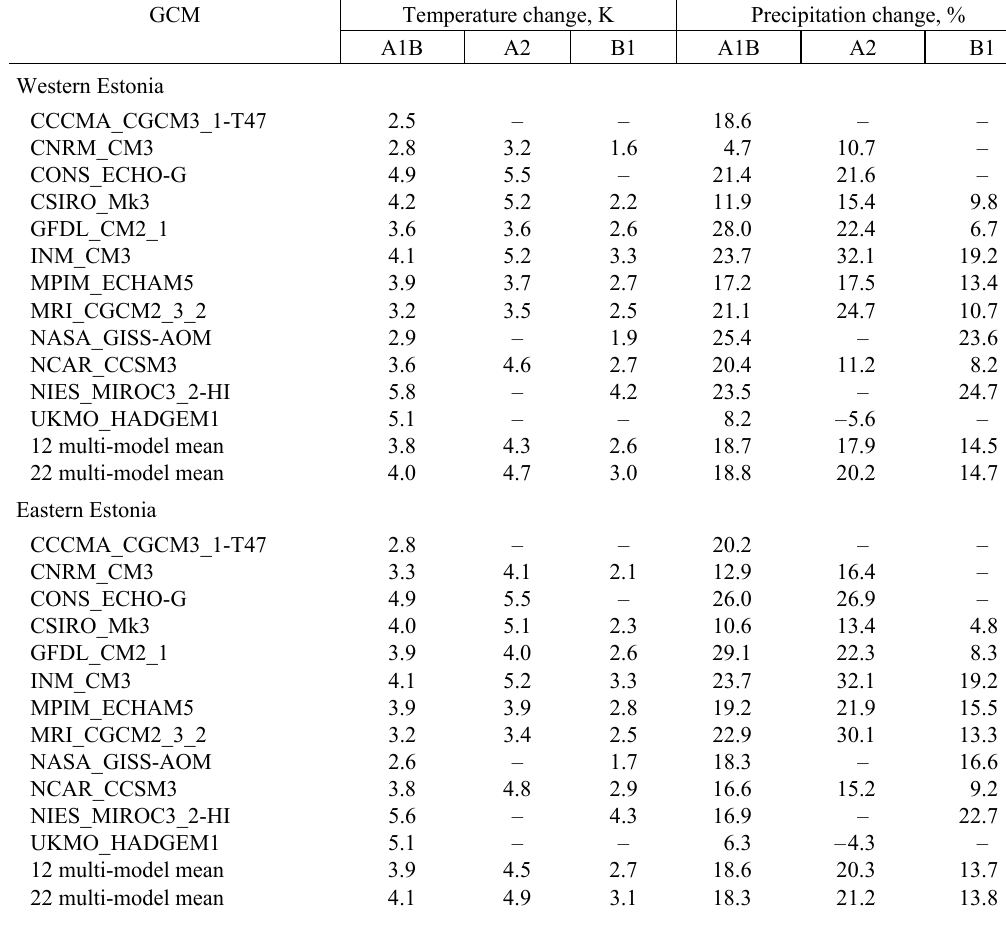
Table 3. Annual mean temperature changes and percentage change of precipitation in western and eastern Estonia projected for 2070(cid:150)2099 according to the SRES emission scenarios and the general circulation models (GCMs) used for AR4 Temperature change,